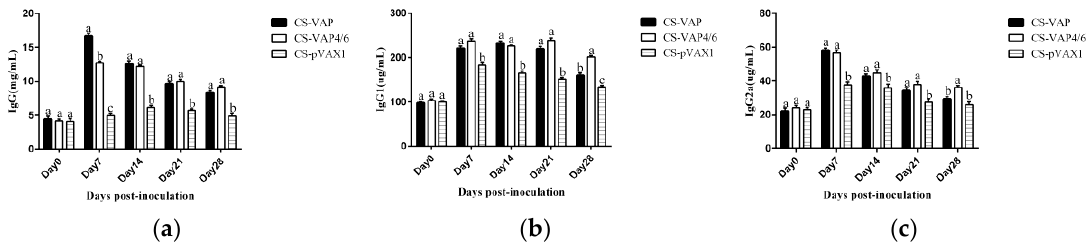
Figure 7. Changes of IgG ( a ), IgG1 ( b ), and IgG2a ( c ) levels of the experimental mice. The IgG, IgG1, and IgG2a levels of each treated group are higher than that of the control group from day 7 to day 28 post-inoculation.